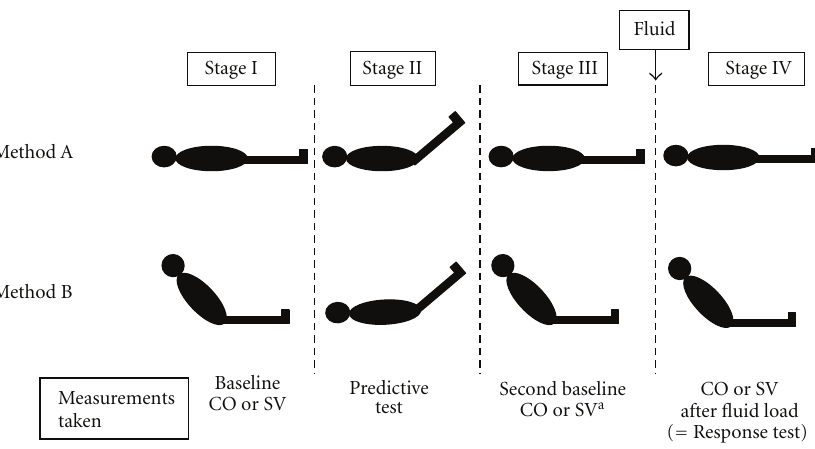
Figure 3: The stages of the two di ff erent methods of passive leg raising. CO cardiac output, SV stroke volume. a Measurements at this stage were not taken in one study